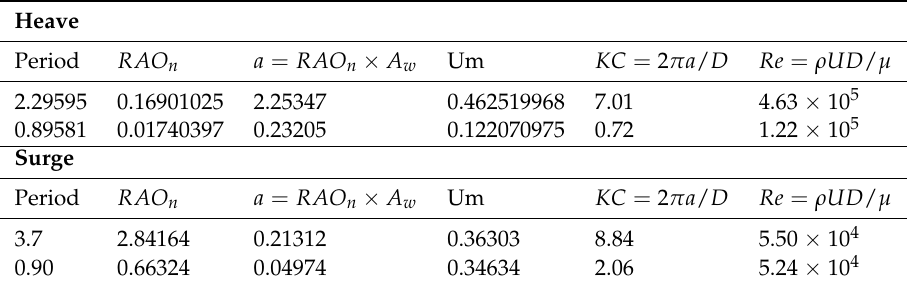
Figure 4. Evaluation of the drag coefficient C d from the curve fitting exercise for surge mode. Here, Exp represents experiment data adapted from [18], with permission from ASME, 2014, and TD represent the time domain computational model with C d = 2.4. Table 1. Maximum and minimum values of the Keulegan–Carpenter (KC) number for the heave and the surge modes corresponding to experiment results for the regular wave of amplitude 75mm—corresponding Re number is also shown.